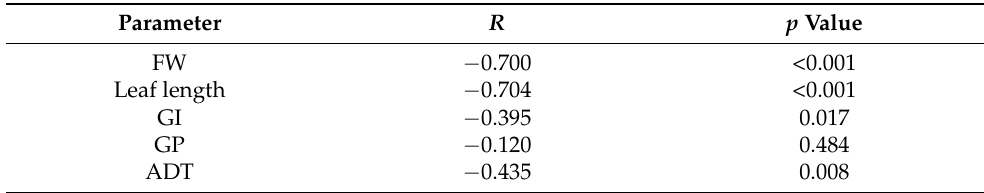
Table 4. Pearson’s correlation coefficient of saponarin content with FW, leaf length, GI, GP, and environmental